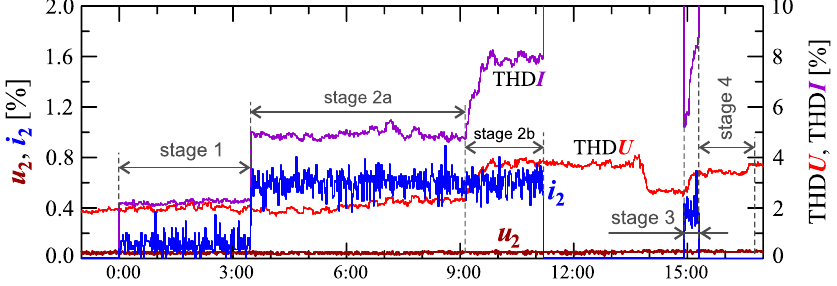
Figure 27. The characteristics of the voltage THD factor THD U = f ( t ) and current THD factor THD I = f ( t ) and the characteristics of the second harmonics of the current i 2 = f ( t ) and voltage u 2 = f ( t ) for Case III.